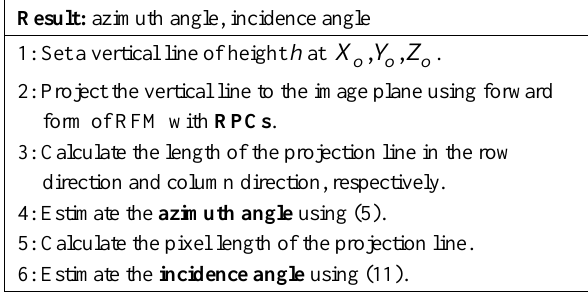
Table 1. Algorithm flow of satellite imaging direction angle